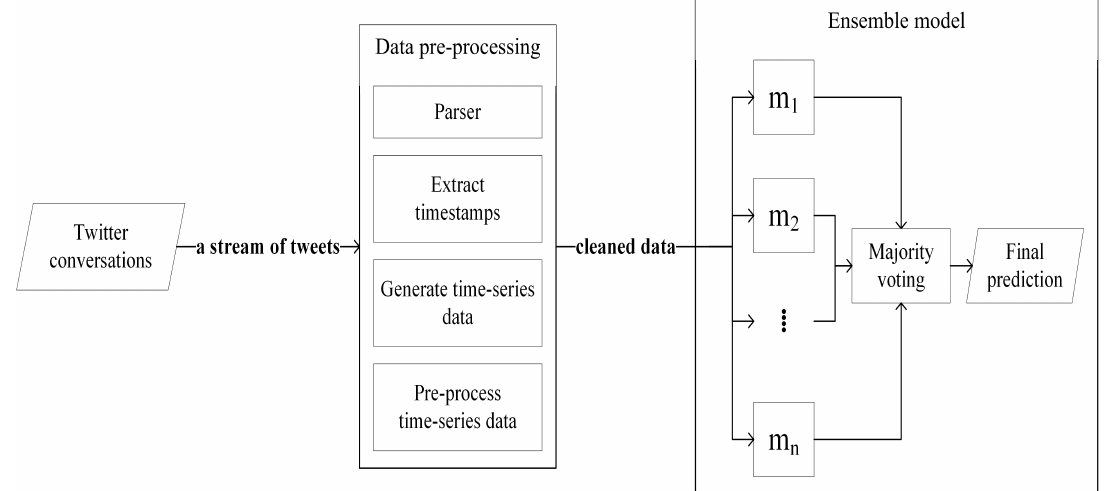
Figure 1. Proposed model for rumor classification taking Twitter conversations as input, which are cleaned in the data pre-processing block and fed as input to the ensemble model that performs the majority voting to determine the final